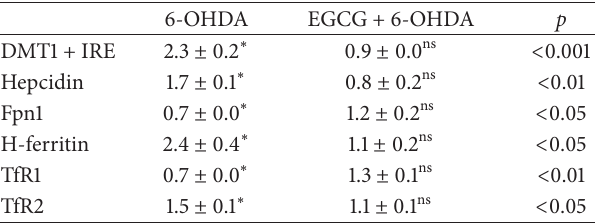
Table 1: Effect of 6-OHDA and EGCG on the iron-related gene expression (mean ± SEM, 𝑛 =